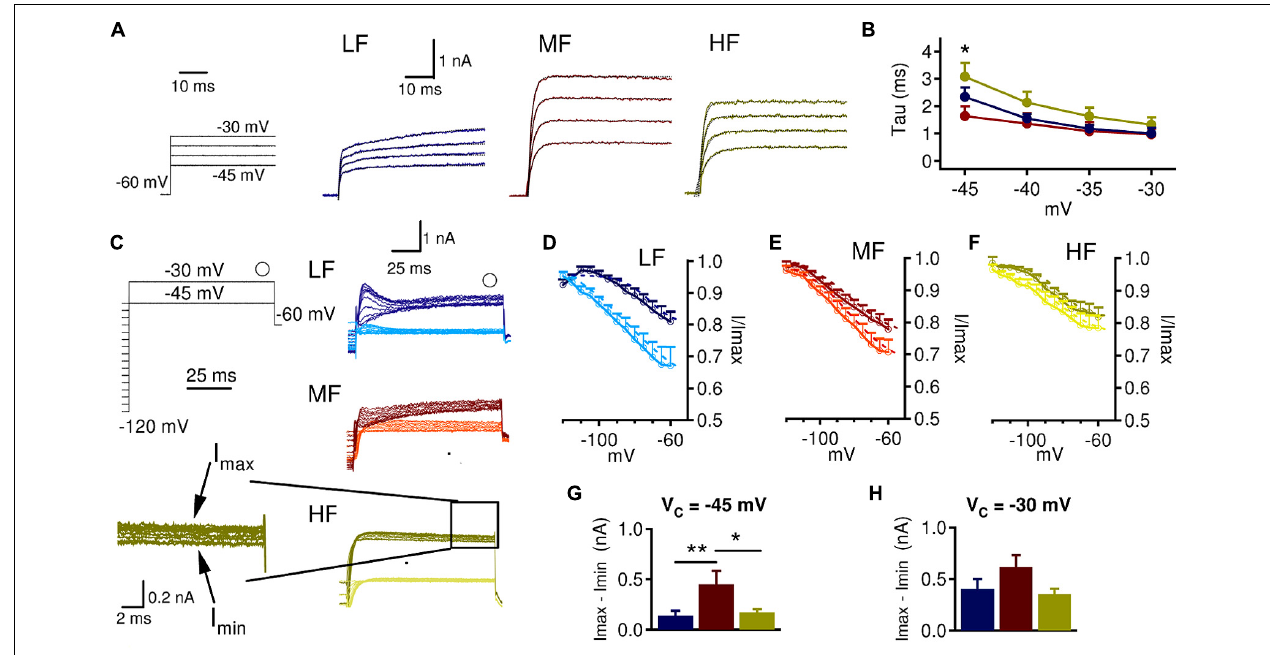
FIGURE 4 | LTK currents in MF neurons are of faster activation and stronger inactivation than in LF and HF neurons. (A) To obtain the time constant ( τ ) for LTK current activation, a single exponential fitting (black dashed line) was performed on the LTK currents recorded at V c from − 45 to − 30 mV (V hold = − 60 mV). (B) At − 45 mV, MF (1.6 ± 0.3 ms) neurons have significantly faster τ than LF (2.3 ± 0.3 ms) and HF (3.1 ± 0.5 ms) neurons. Kruskal–Wallis tests with follow-up Mann–Whitney U -tests. (C) Sample protocol used to study LTK inactivation at − 45 and − 30 mV following increasing voltage steps ( − 120 to − 45 mV, 100 ms duration, and 5 mV increment). The open circle indicates where I SS was measured. The traces with darker colors were obtained at − 30 mV and those with lighter colors at − 45 mV. Inset shows the I max and I min used to calculate the